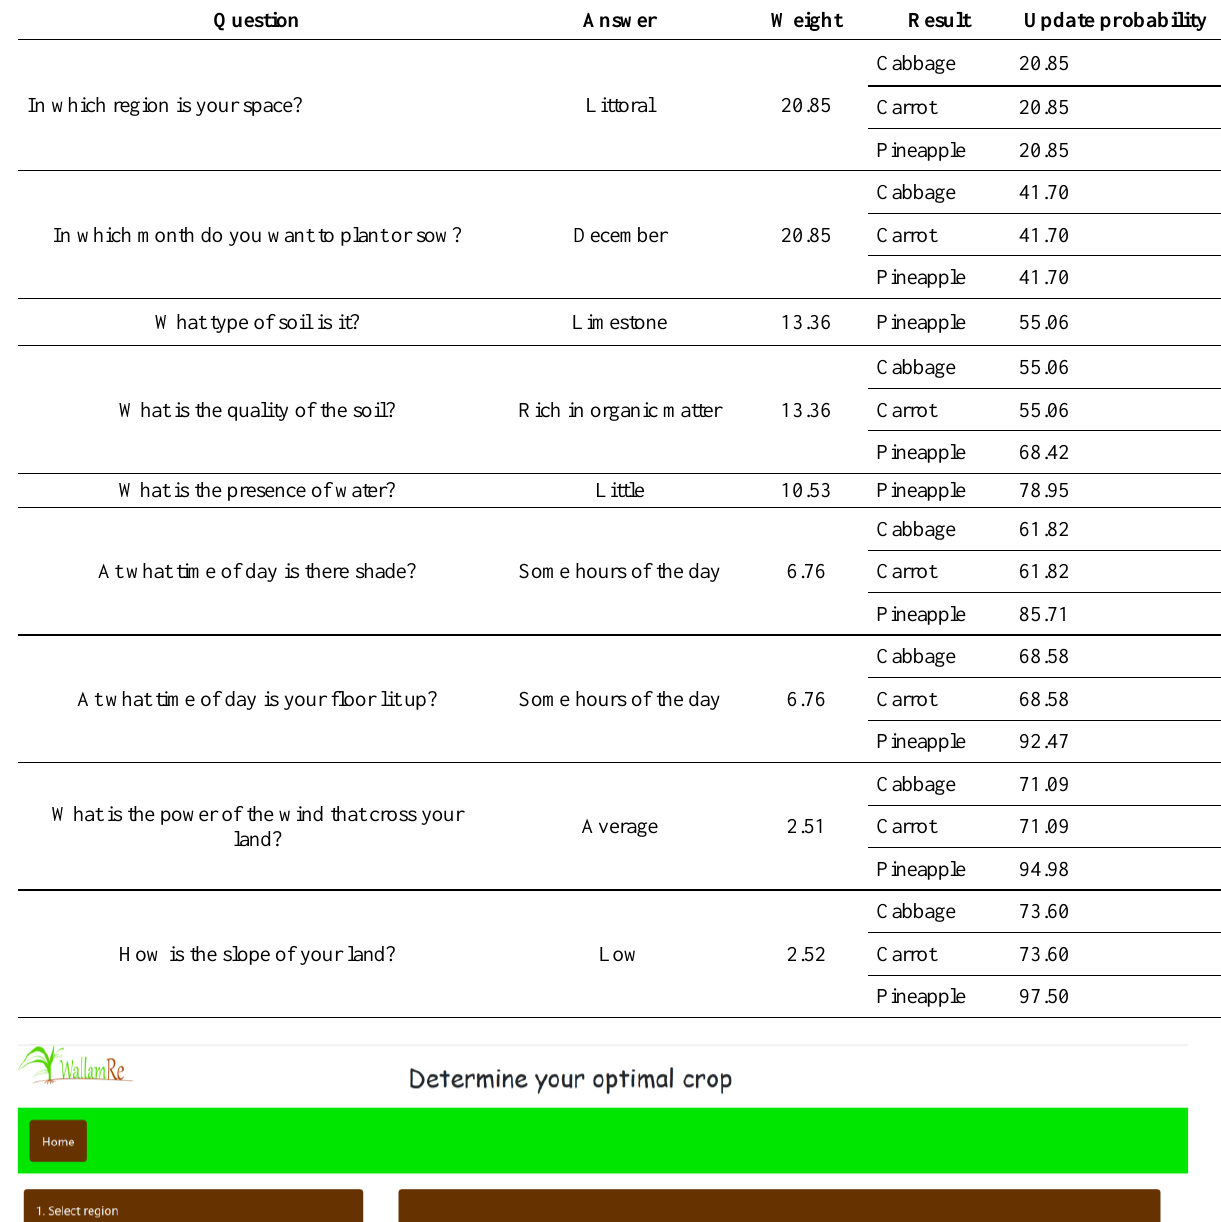
Table 8. Application of backward chaining on three crops